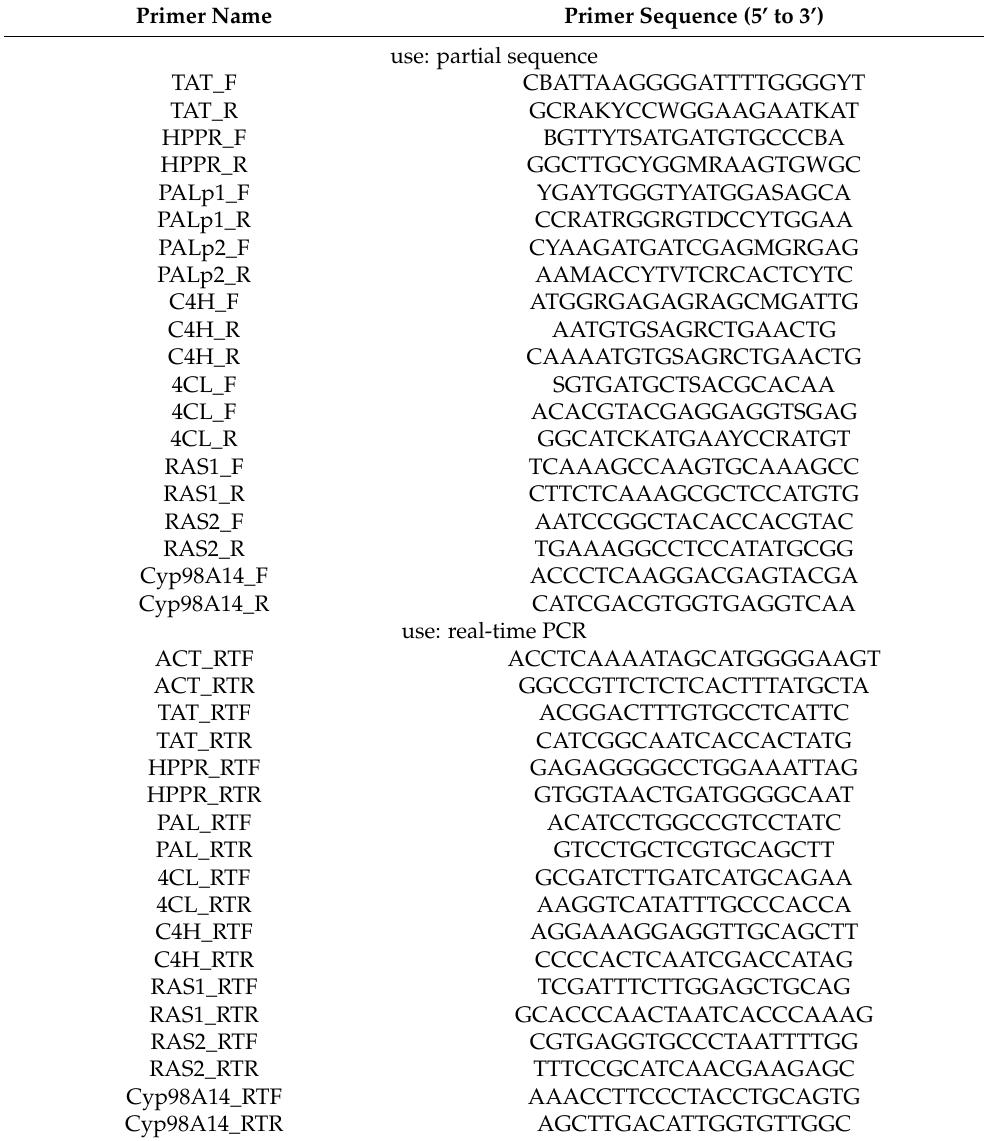
Table 1. Primers designed and used in this